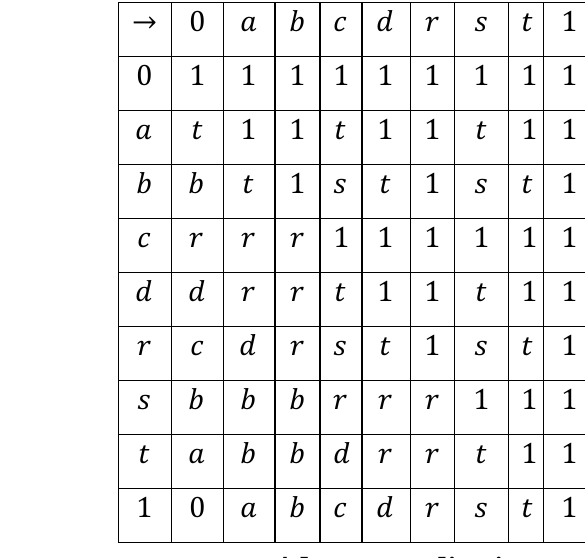
Table 3.1: Complement Table 3.2: